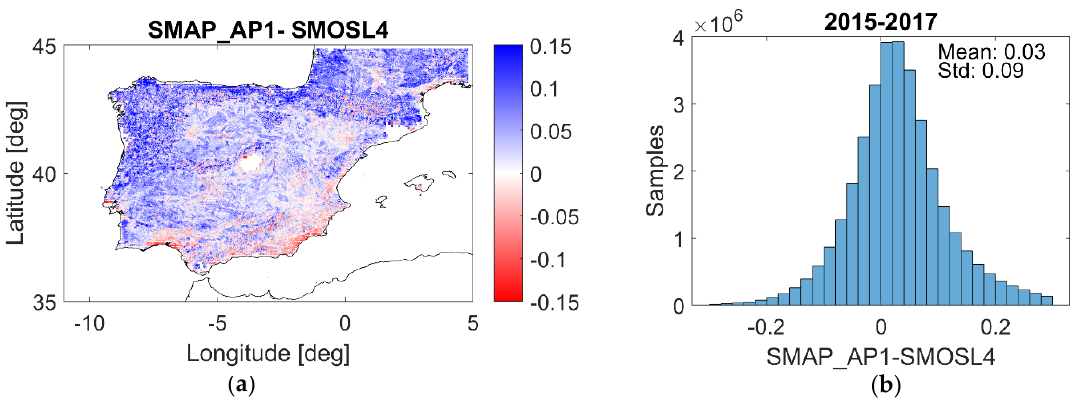
Figure 5. ( a ) Temporally-averaged map of daily SSM differences between SMAP and SMOS at 1 km (SMAP_AP1 minus SMOSL4) and ( b ) histogram of daily SSM differences maps, for the period April